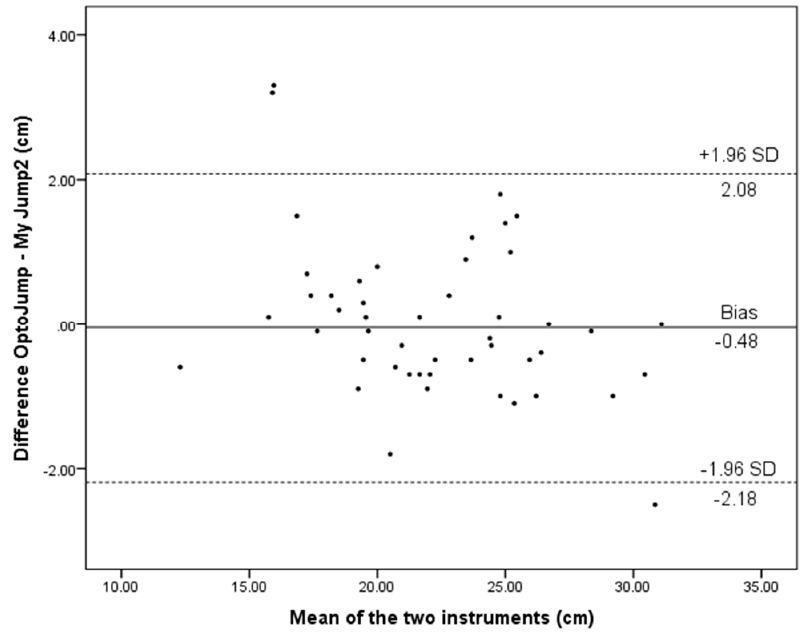
Figure 3. Level of agreement (Bland–Altman) with 95% limits of agreement (dashed lines) and the mean di ff erence (solid line) between My Jump 2 and the OptoJump for CMJ in the whole sample.